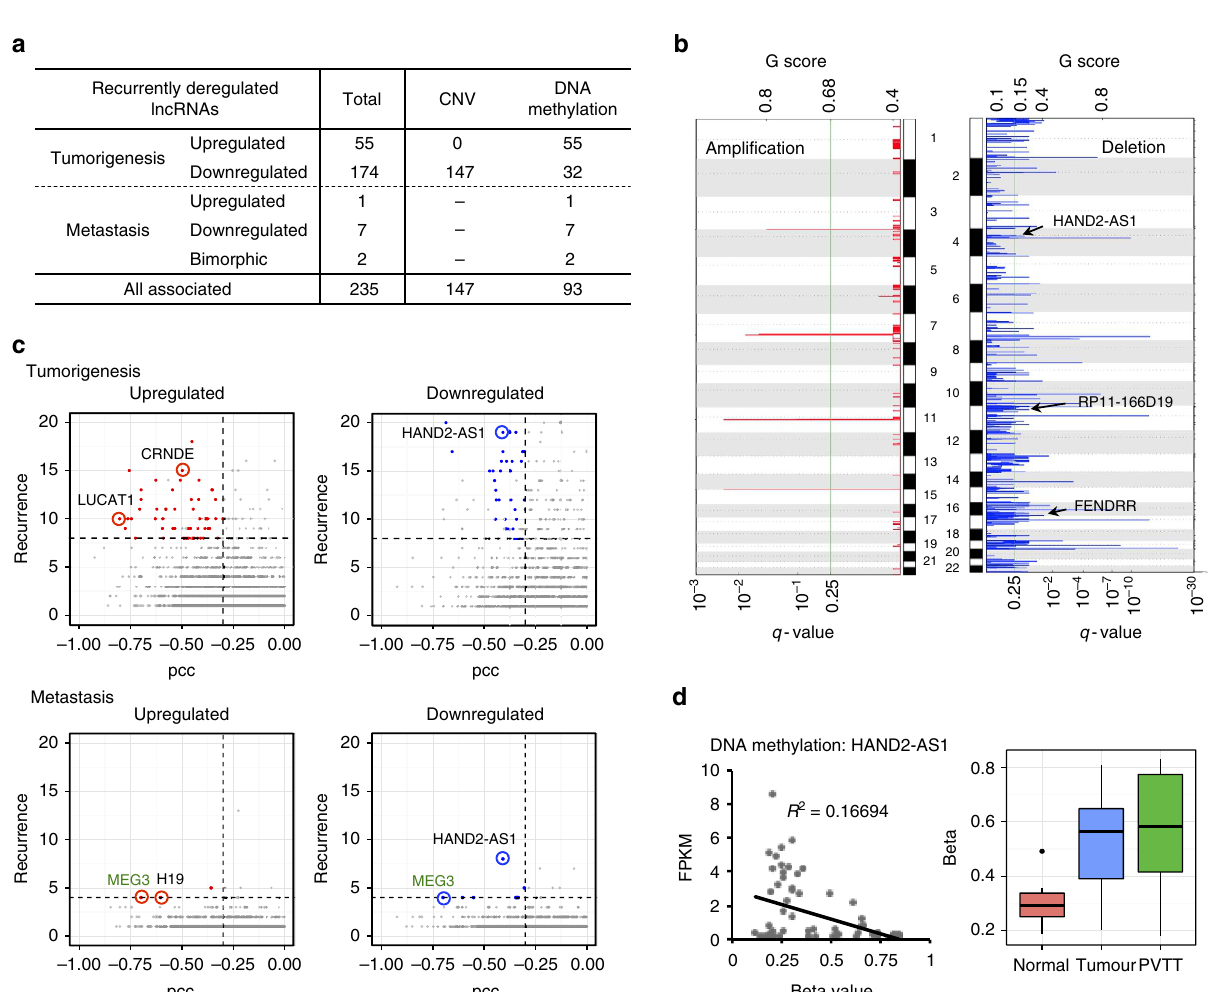
Figure 4 | Regulatory mechanisms for recurrently deregulated lncRNAs. ( a ) Summary of the regulatory mechanisms of recurrently deregulated lncRNAs. The numbers of lncRNAs associated with CNV and/or DNA methylation data are listed. Bimorphic lncRNAs were those that were recurrently upregulated in some patients and recurrently downregulated in other patients. The total number of lncRNAs is not equal to the sum of each type because of overlapping sub-types. ( b ) Chromosomal view of amplification and deletion peaks between primary tumours and normal tissue. The G-scores (top) and FDR q-values (bottom) of peaks were calculated using GISTIC2.0. The G-score considered the amplitude of the aberration and its frequency of occurrence across all samples. The q-value was calculated for the observed gain/loss at each locus using randomly permuted events as a control. Examples of recurrently deregulated lncRNAs located in the peaks (only found in deletions) are labelled. ( c ) Scatterplots showing recurrently deregulated lncRNAs (colour labelled) that were putatively affected by alterations in DNA methylation. Recurrently deregulated lncRNAs driven by DNA methylation had expression levels that were inversely correlated with DNA methylation levels at their promoter regions (PCC, Pearson correlation coefficients o (cid:2) 0.3, x axis). ( d ) Example of a recurrently deregulated lncRNA driven by DNA methylation; the HAND2-AS1 expression level (FPKM) was inversely correlated with its promoter methylation level (beta value). Boxplot showing that the beta values of primary tumour samples were significantly higher than those of normal tissue samples, but slightly lower than those of PVTT